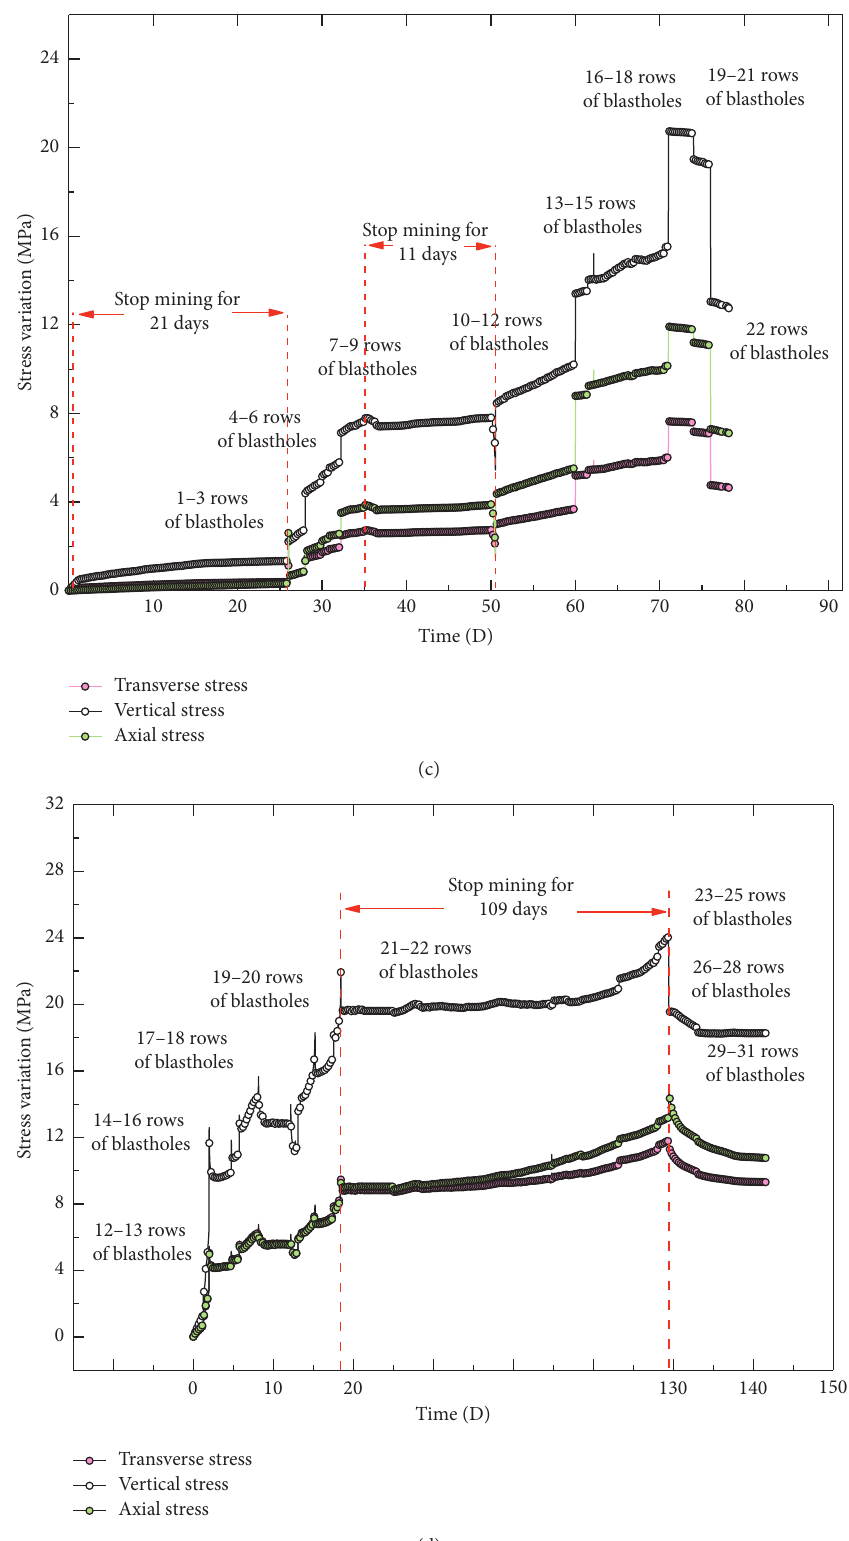
Figure 4: Dynamic monitoring data of stope mining-induced pressure in the whole process. (a) − 325 horizontal section, (b) − 350 horizontal section, (c) − 375 horizontal section, and (d) − 400 horizontal